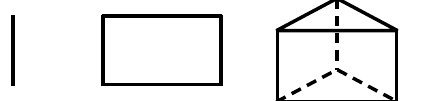
Figure 1. Extruded mesh entities belonging to the base mesh to be extruded (left to right): vertices, horizontal edges, horizontal facets.